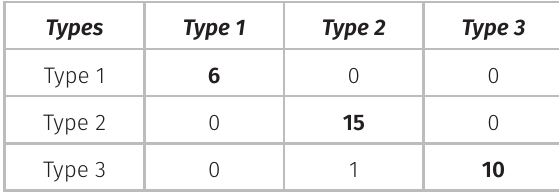
Table II. Confusion Matrix of Random Forest.